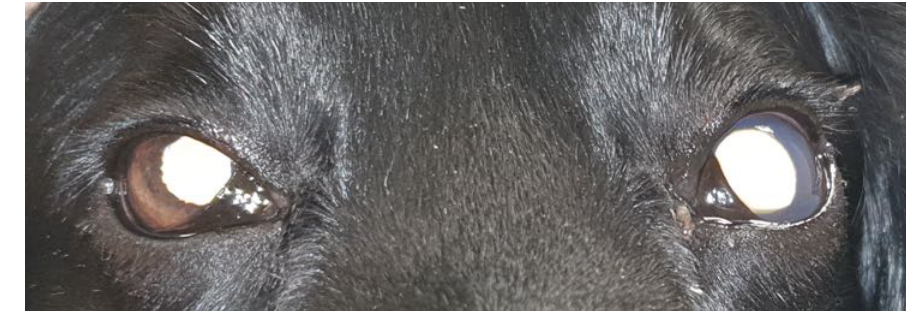
Figure 4. English Cocker Spaniel, 8yo FN- Primary closed angle acute congestive glaucoma left eye, note the anisocoria with dilated left pupil, diffuse corneal oedema, third eyelid protrusion (North Downs Specialist Referrals) Clinical signs of acute onset glaucoma (more common in primary glaucoma